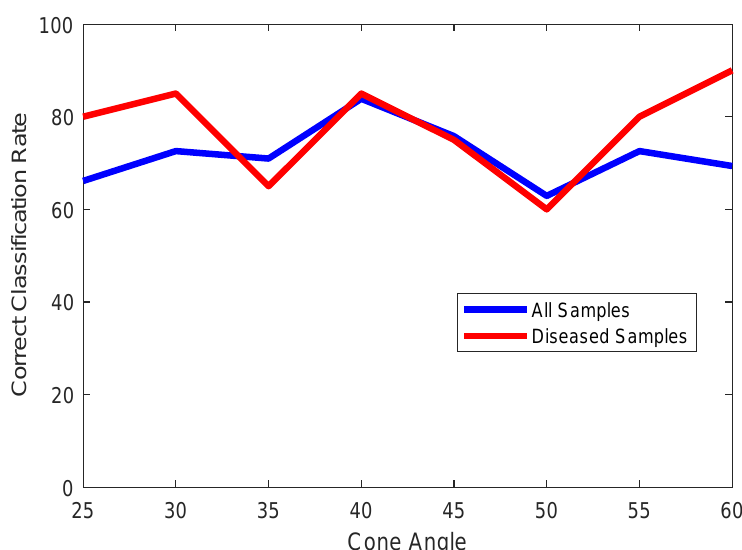
Figure 6. Plot of classification accuracies of all samples (blue) and only diseased samples (red) vs. cone angles of prongs.